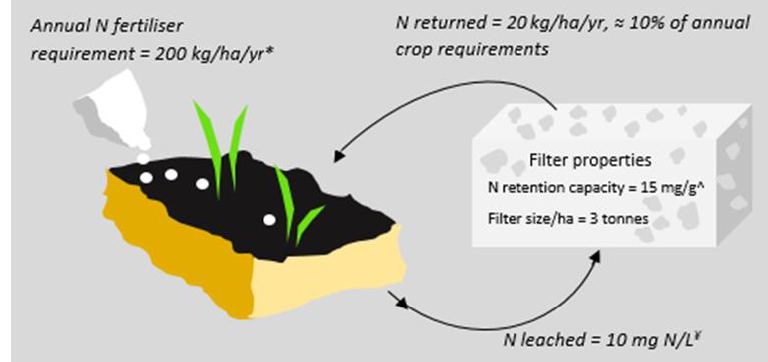
Figure 2. Schematic depicting how geo-amendments (e.g., clays, zeolites, or iron hydroxides) could be used to intercept nitrogen (as either NH 4+ or NO 3− ) from agricultural runoff and then used as soil amendments for N supply once their filtering capacity becomes exhausted. References for calculation estimates: * from Rowlings et al. [80], ^ = capacity based on average N sorption capacity for zeolites from Wang et al. [66] and hydroxides from Terry [76]. Filter size estimated from performance under a hydraulic retention time of 10 h, based on average irrigation (not rainfall) runoff flow of 3000 m 3 /ha/year for cane and banana farms in Queensland from Faithful et al. [81] and, assuming bulk density of 1.5 t/m 3 for typical packed silicate minerals, the ¥ average of estimate range from Faithful et al. [81] and Wang et al. [66] for agricultural runoff.